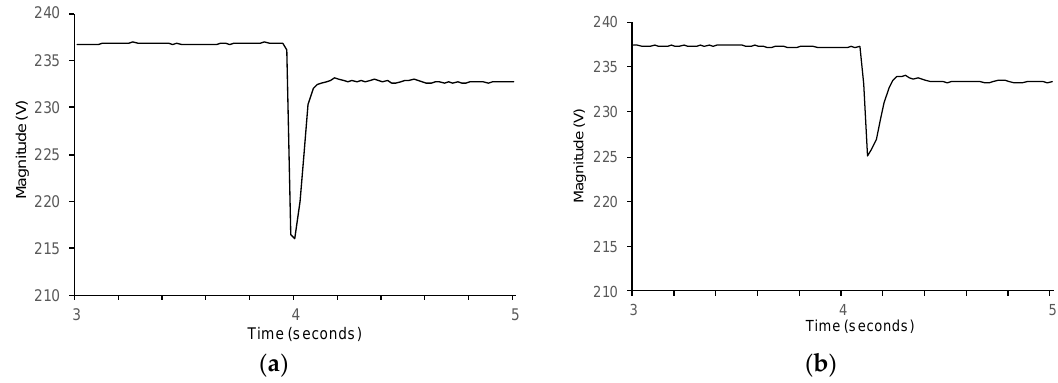
Figure 5. Examples of rapid voltage changes produced by DC motor starting.